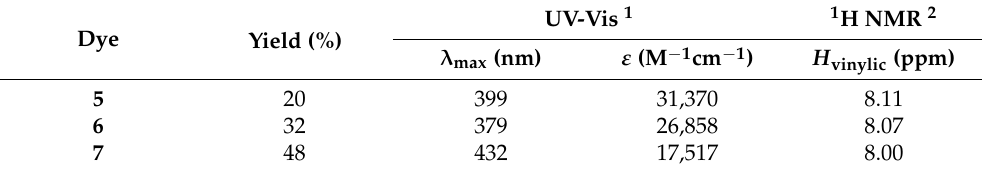
Table 1. Reaction yields and data from UV-Vis spectra and 1 H NMR for push-pull heterocyclic dyes 5–7 .